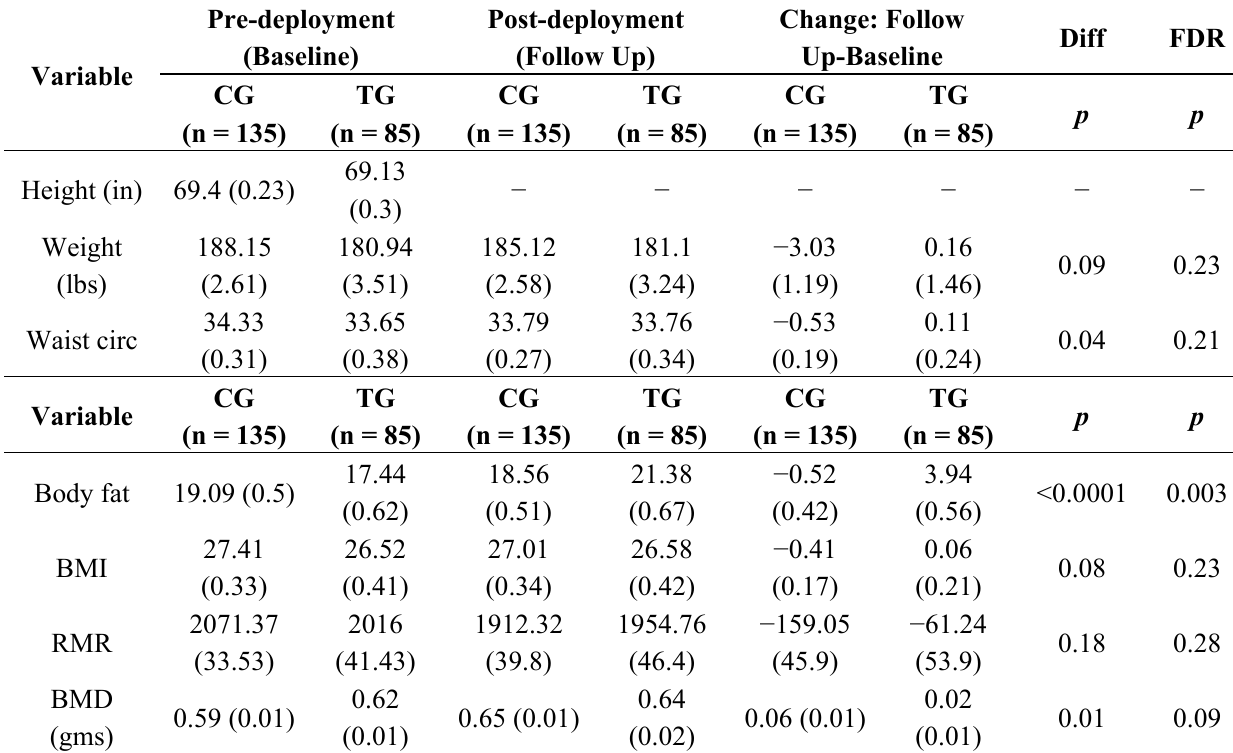
Table 2. Pre- to post-deployment changes in